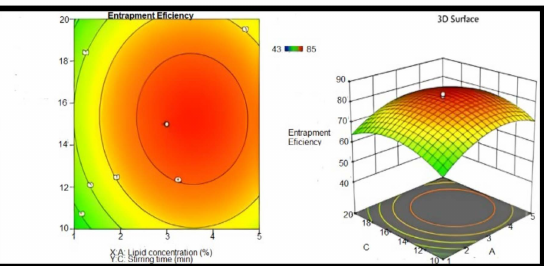
Figure 9. Counter and response surface plots of entrapment efficiency (stirring time and lipid concentration), n = 6.